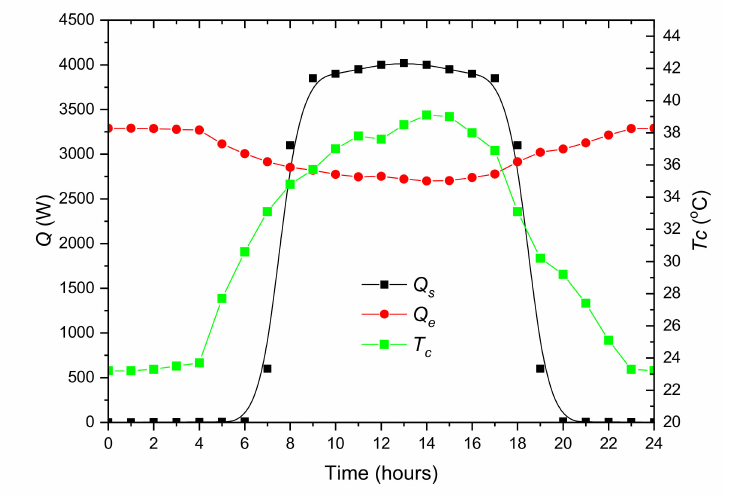
Figure 5. Hourly profiles of the office building internal cooling load Q s , compressor unit cooling capacity Q e and condensing temperature T c